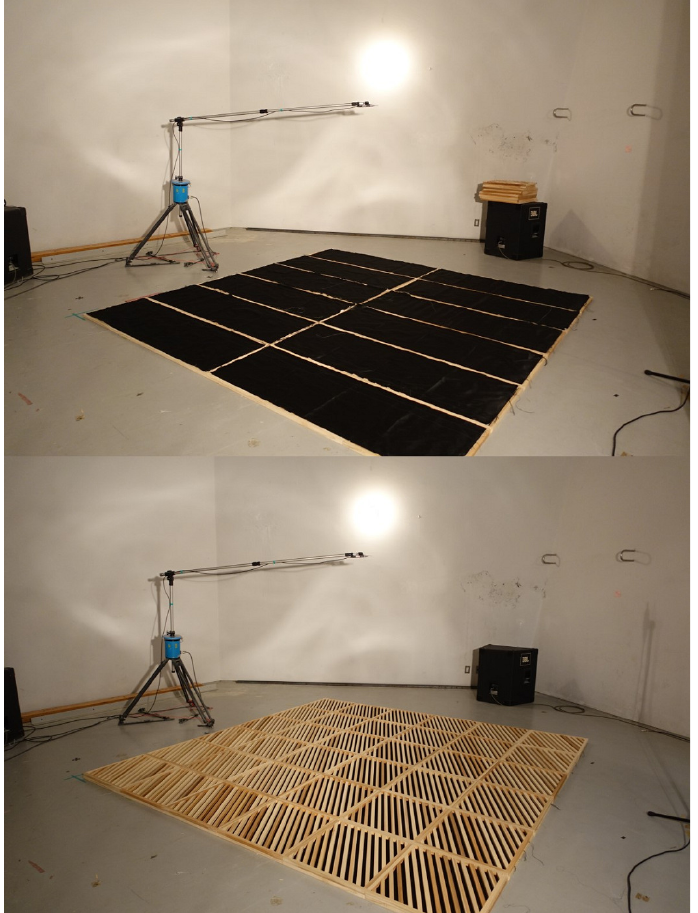
Figure 5. Laying a sound-absorbing layer on R-1 ( Upper ), and a sound absorption measurement of the CRD-A ( Lower ).